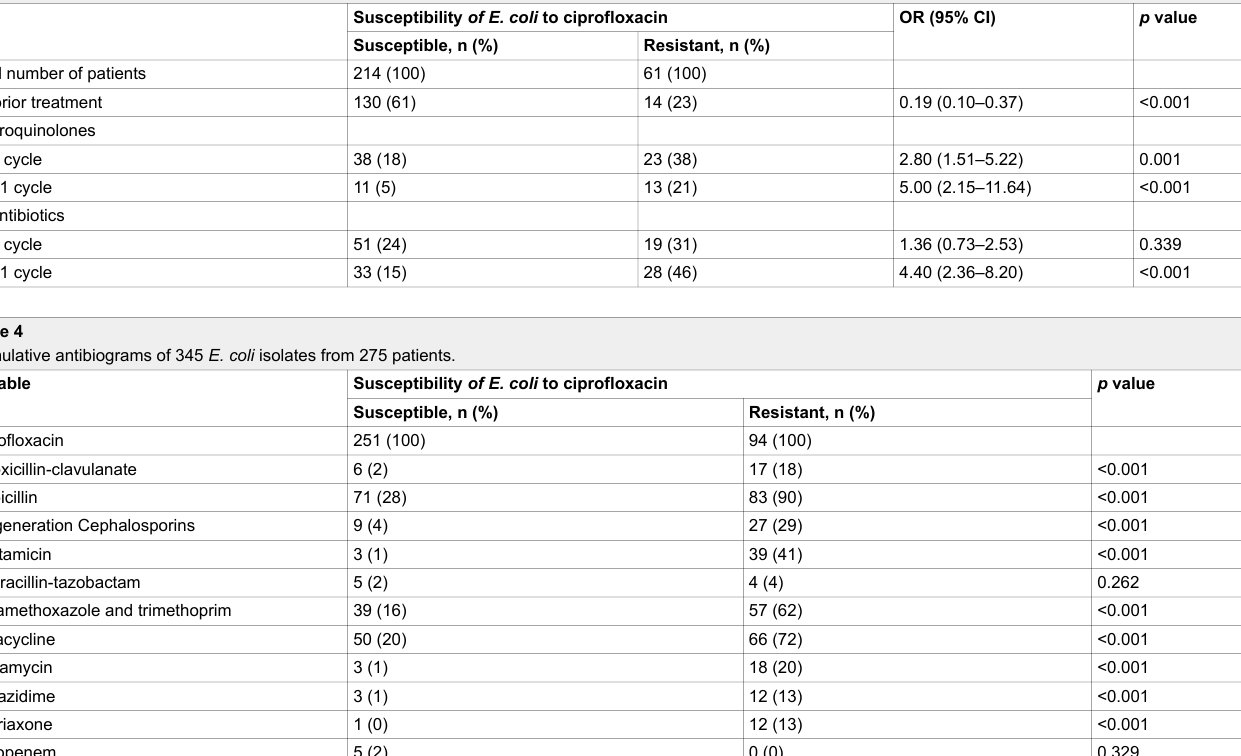
Table 3 Antibiotic treatment within the previous 365 days.